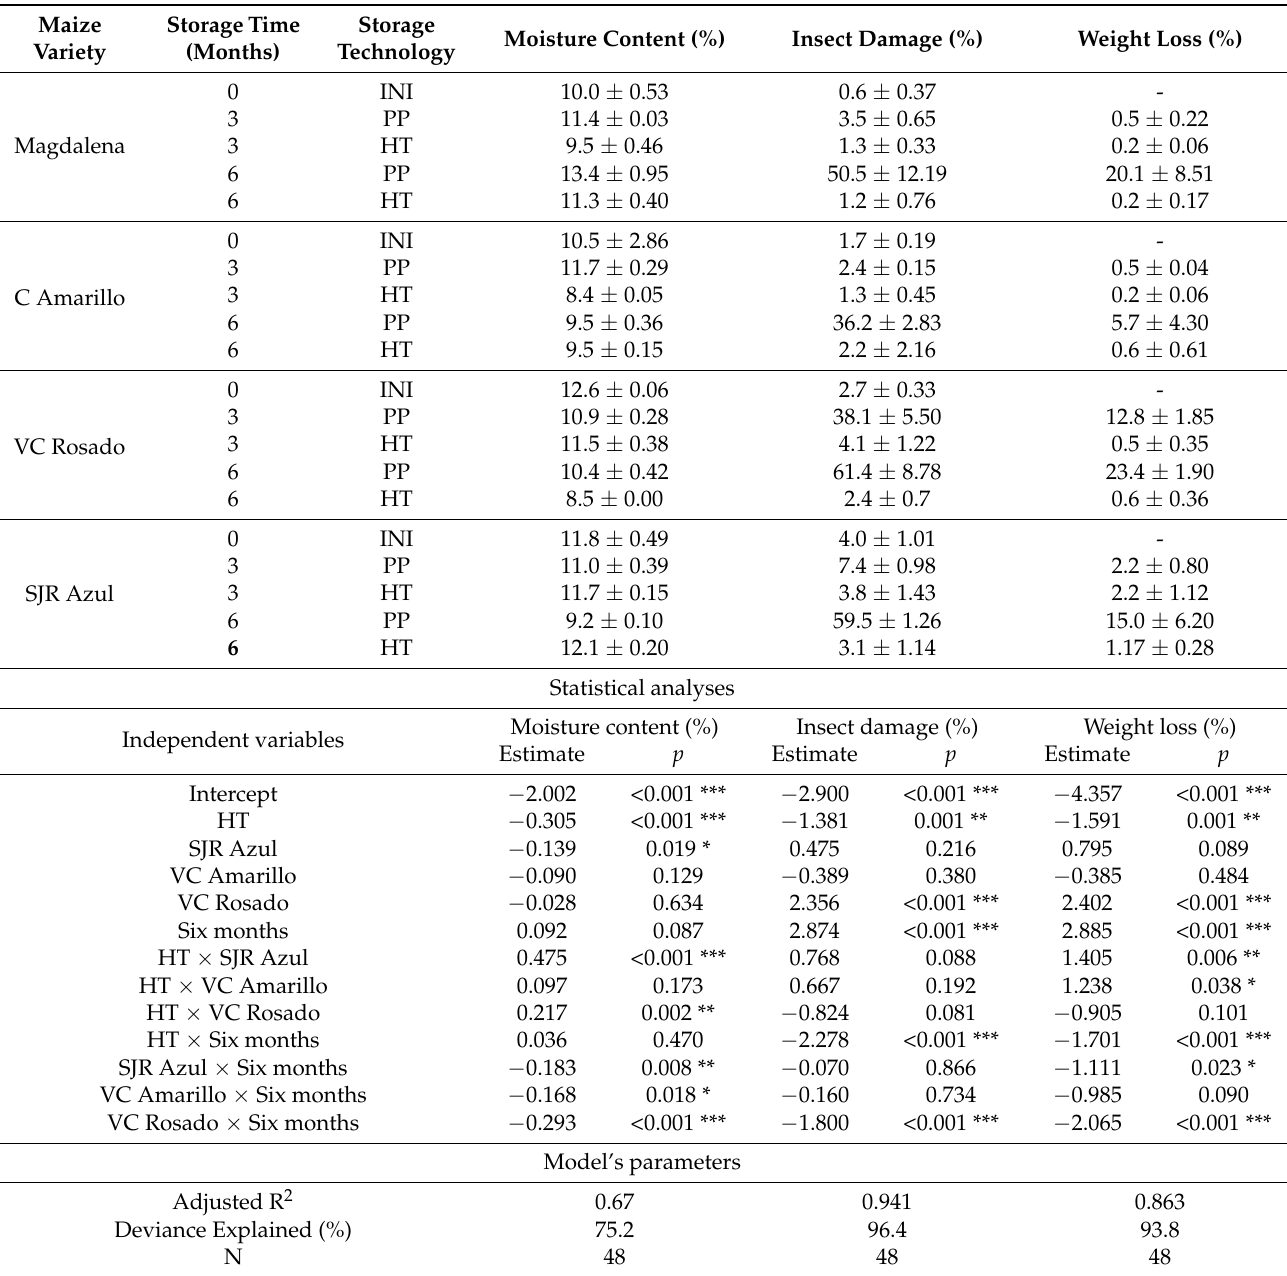
Table 2. Average moisture content and damage ( ± standard deviation) after 3 and 6 months of